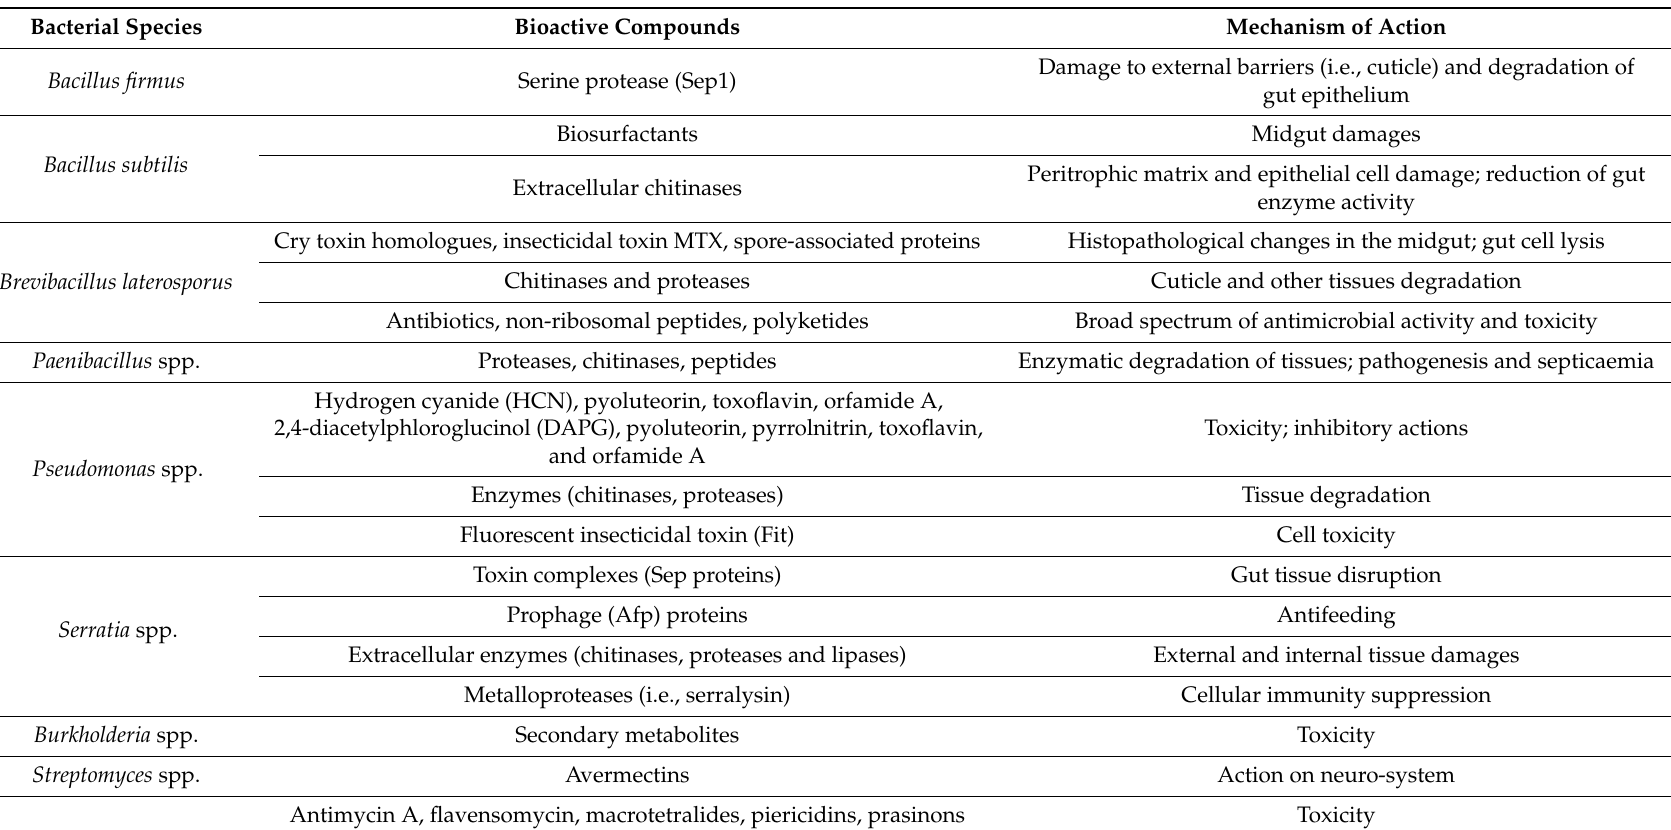
Table 2. Representative bioactive compounds produced by some PGPB species against invertebrate